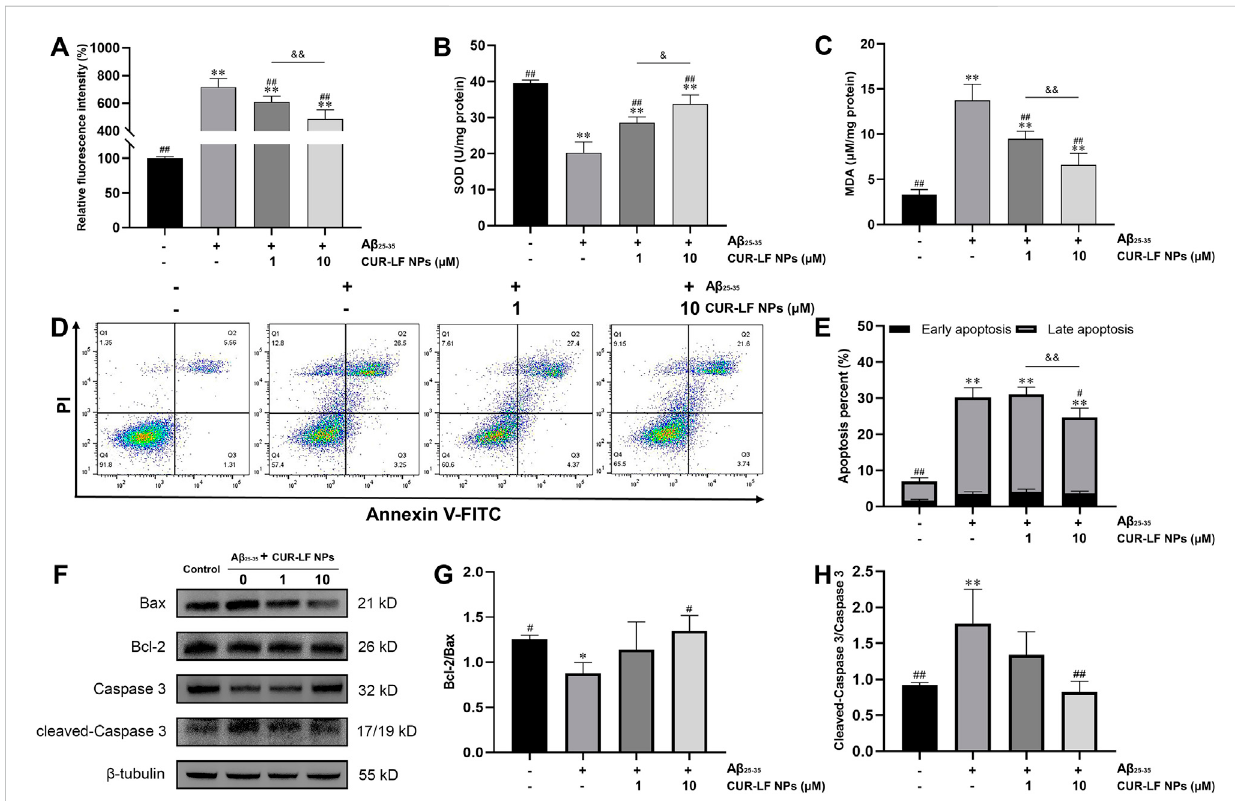
Protective effect of CUR-LF NPs on A β 25-35 -induced oxidative stress and apoptosis in PC12 cells (A) DCFH-DA fl uorescence probe was used to detect intracellular ROS generation in PC12 cells (B) The intracellular SOD activity was measured using an SOD assay kit (C) The intracellular MDA level wasevaluated with an MDA assay kit (D) Apoptosis of thetreated PC12 cells wasanalyzed by fl ow cytometry using Annexin V-FITC/PIkit (E) Early and late apoptosispercentofPC12cells (F) RepresentativewesternblottingimagesofBax,Bcl-2,Caspase3,cleaved-Caspase3,and β -tubulin;Quantitation of Bcl-2/Bax ratio (G) and cleaved-Caspase 3/Caspase 3 ratio (H) . * p < 0.05, ** p < 0.01 versus control group; # p < 0.05, ## p < 0.01 versus A β 25 – 35 group. & p < 0.05, && p < 0.01 low dose treatment group (1 μ M) versus high dose treatment group (10 μ M). Data were presented as mean ± SD (n = 3).